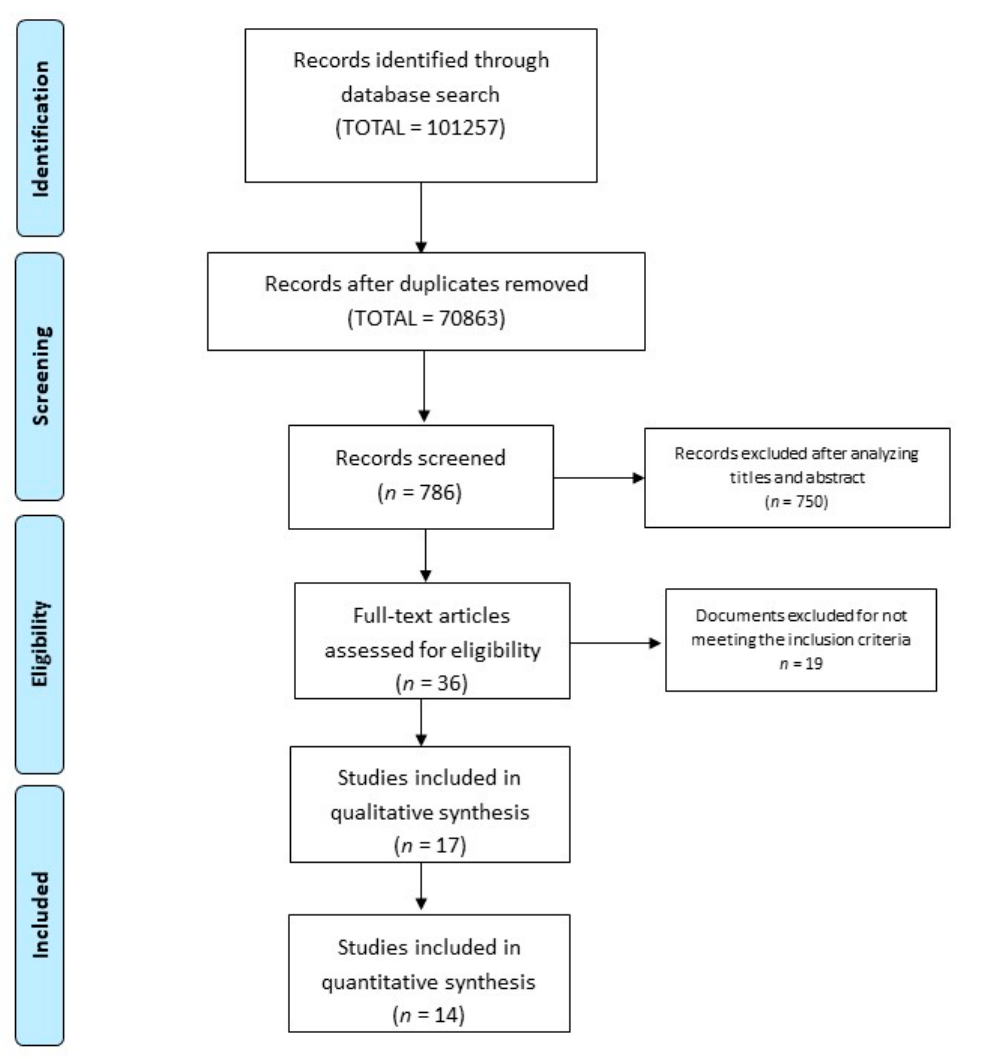
Figure 1. Study selection flow diagram.